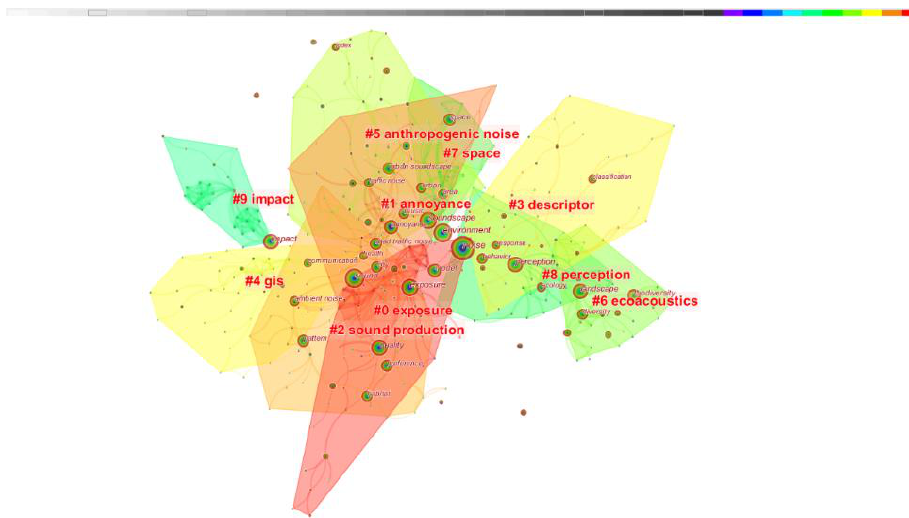
Figure 10. Clustering map of keyword co-occurrence in soundscape research.